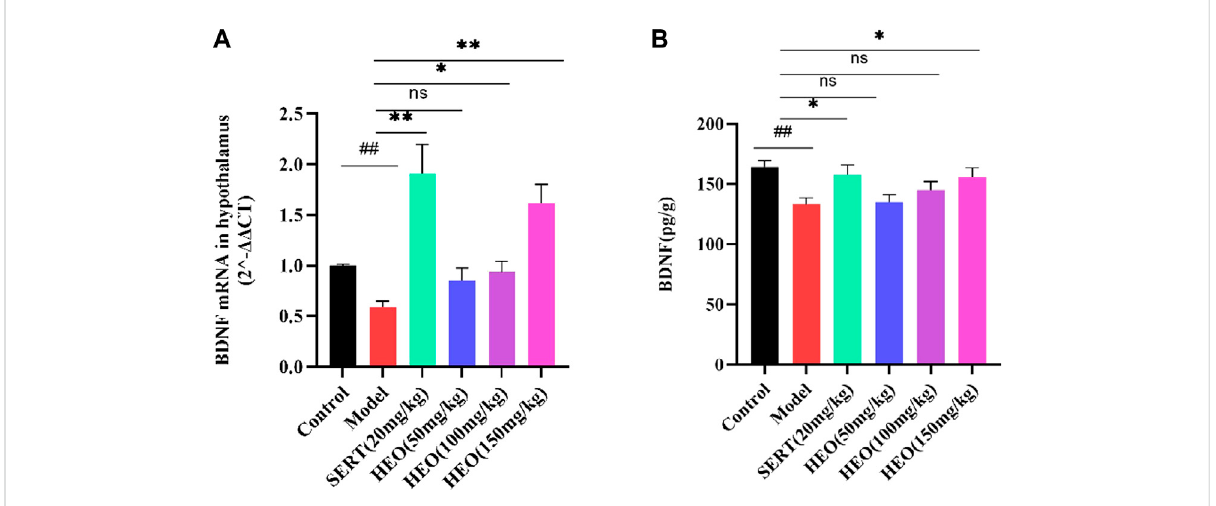
FIGURE 6 Effects of HEO on BDNF mRNA (A) and protein (B) expressions in the hippocampus. Data were expressed as mean ± SEM ( n = 6). ## p < 0.01 vs control group; * p < 0.05, ** p < 0.01 vs the CUMS group. BDNF, brain-derived neurotrophic